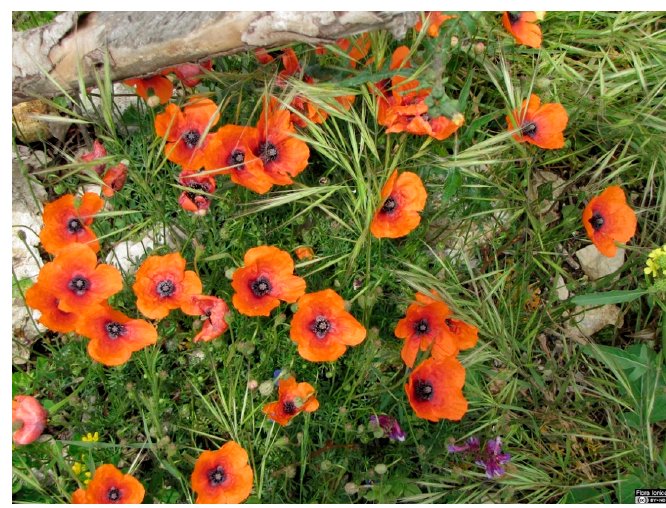
Figure 26. ( a ) Pinks ( Dianthus tarentium ). Photograph courtesy of Wikimedia Commons. ( b ) Sage-leaved rock rose ( Cistus salviifolius ). Photograph courtesy of Wikimedia Commons. ( c ) Boston, Museum of Fine Arts 76.54 Apulian oinochoe (type 1), close to or by the Baltimore Painter, ca. 330–320 B.C. Female head in profile to left emerging from flower flanked by floral tendrils. Photograph © Museum of Fine Arts, Boston.